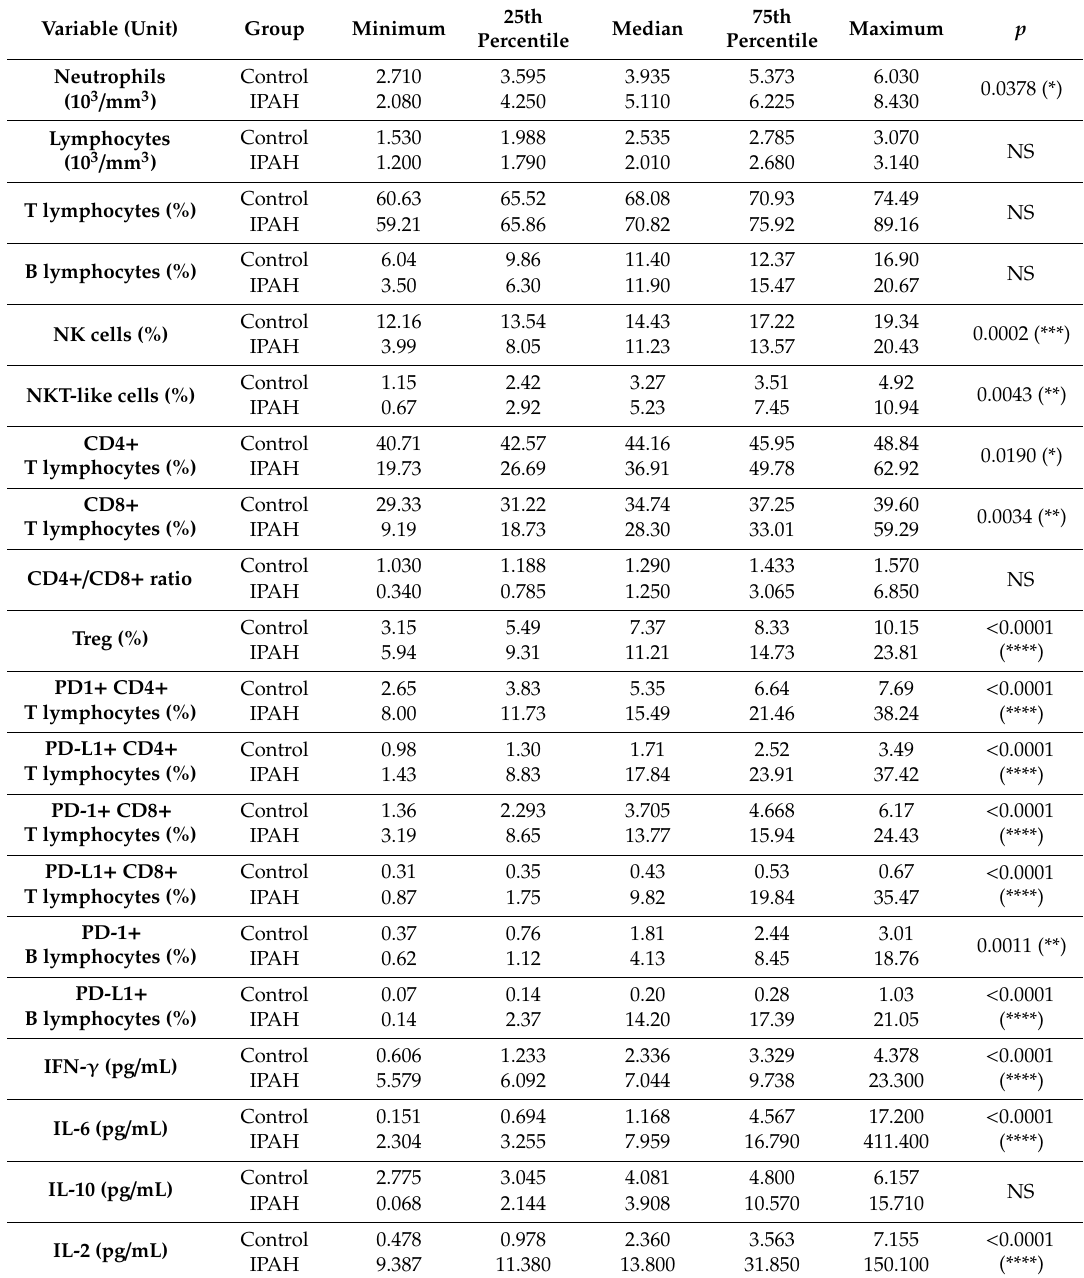
Table 1. Results of the immunophenotyping of the peripheral blood and the plasma cytokine determination of the IPAH patients and corresponding controls. Cells were enumerated and presented either as No / vol or proportion of cells given as % of specific subpopulation within the leukocyte (CD45 + ) population. Statistical significance was determined with nonparametric Mann–Whitney test; p values below 0.05 were considered significant, and * denotes p ≤ 0.05, ** p ≤ 0.01, *** p ≤ 0.001, and **** p ≤